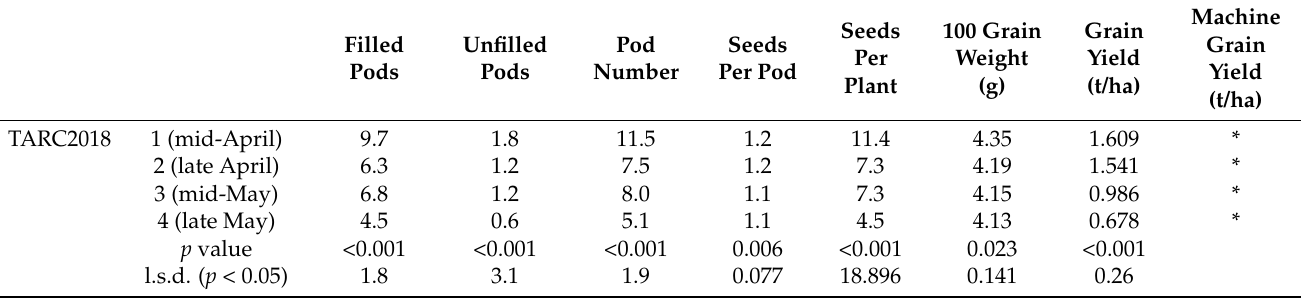
Table 4. Influence of sowing date on lentil grain yield and yield components. * = data not